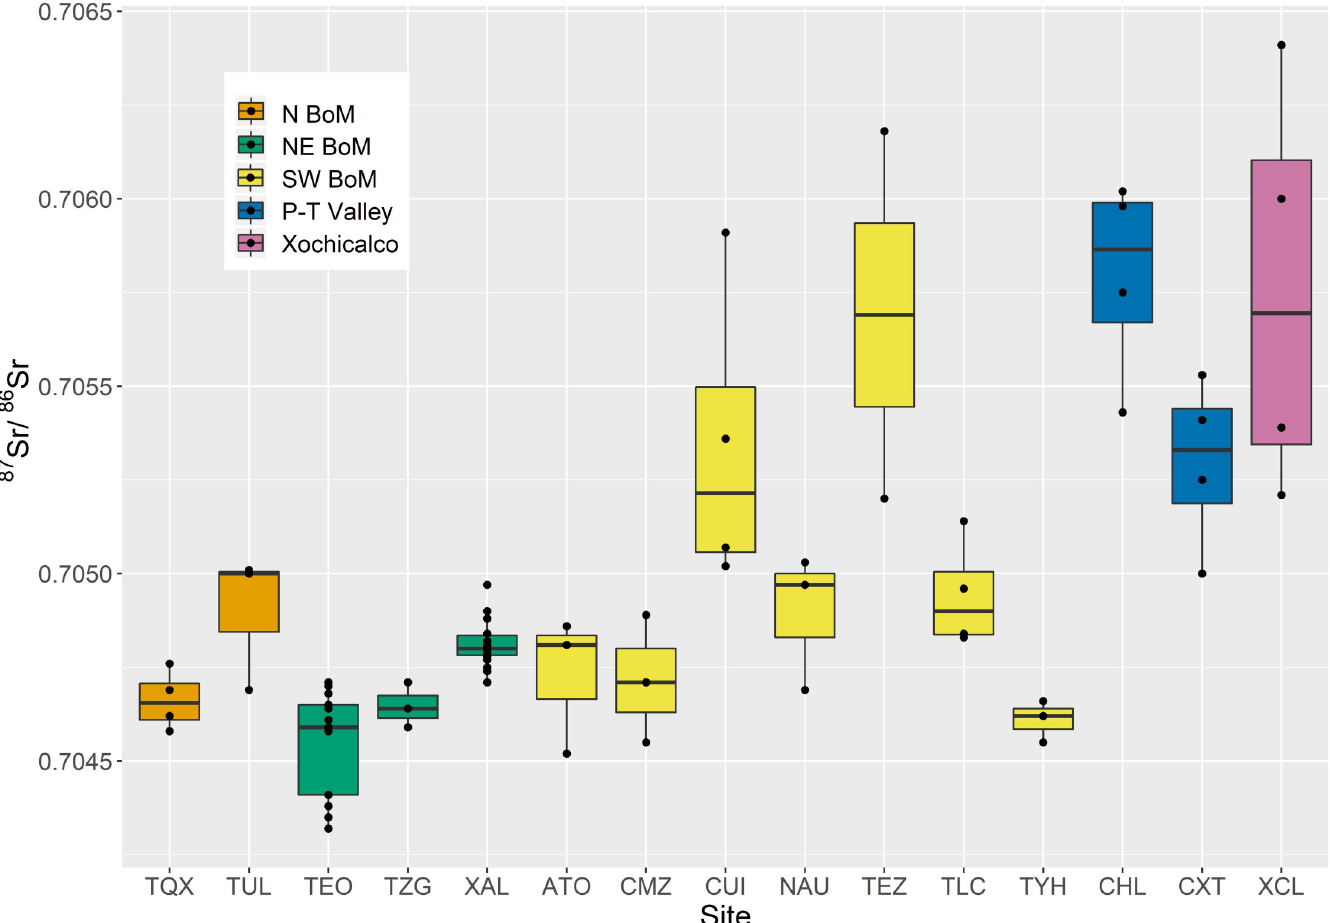
Fig 4. 87 Sr/ 86 Sr interquartile ranges of central Mexican sites, shaded by cluster. Individual data points are overlain. TQX = Tequixquiac, TUL = Tula, TEO = Teotihuacan, TZG = Texcotzingo, XAL = Xaltocan, ATO = San Pedro Atocpan, CMZ = Cerro Moctezuma, CUI = Cuicuilco, NAU = Naucalli, TEZ = Tezozomoc, TLC = Tlatelolco, THY = Santiago Tulyehualco, CHL = Cholula, CXT = Cacaxtla, XCL = Xochicalco.